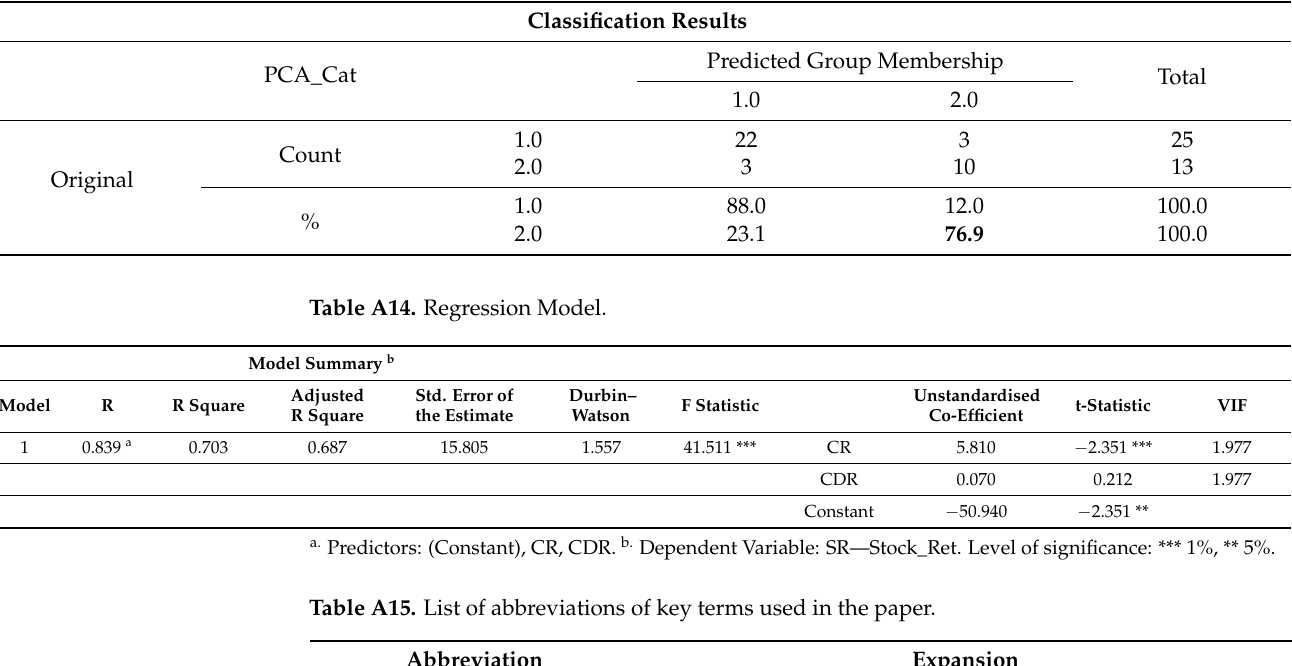
Table A13. Classification Summary—Combined Model.